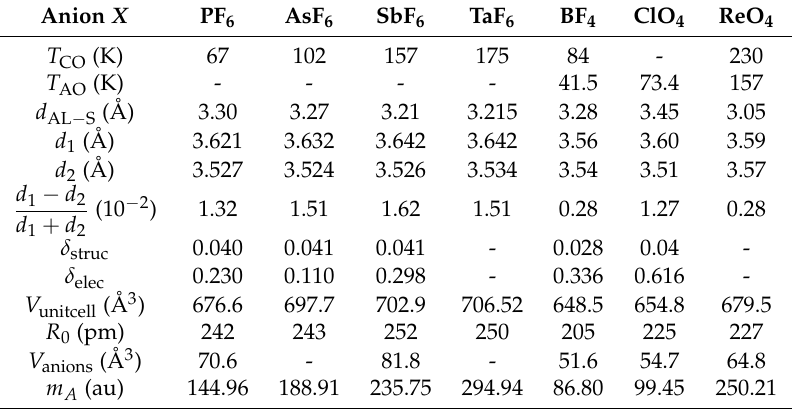
Table 1. Overview on the transition temperatures T CO and T AO , as well as on the room-temperature structural data of various (TMTTF) 2 X salts with octahedral and tetrahedral anions X . Here d AL − S is the shortest distance between the anion-ligand (F or O) and the sulfur atom. d 1 and d 2 denote the distances between planes defined by the TMTTF molecules within one stack [9,11–13,18]. Hence, ( d − d ) / ( d + d ) denotes the structural dimerization along the stacks determined by the distance 2 2 1 1 between the TMTTF molecular planes; it does not take into account any displacement of the molecules along the b or c direction. In contrast to that, δ struc and δ elec are determined by ab-initio DFT calculations based on X-ray structural data [49,50]. δ struc corresponds to a structural dimerization as well, which is defined by the distance between the centers of mass in each TMTTF molecule. δ elec = 2 | t 1 − t 2 | / ( t 1 + t 2 ) explicitly takes into account the overlap of the transfer integrals t 1 and t 2 . The unit cell volume